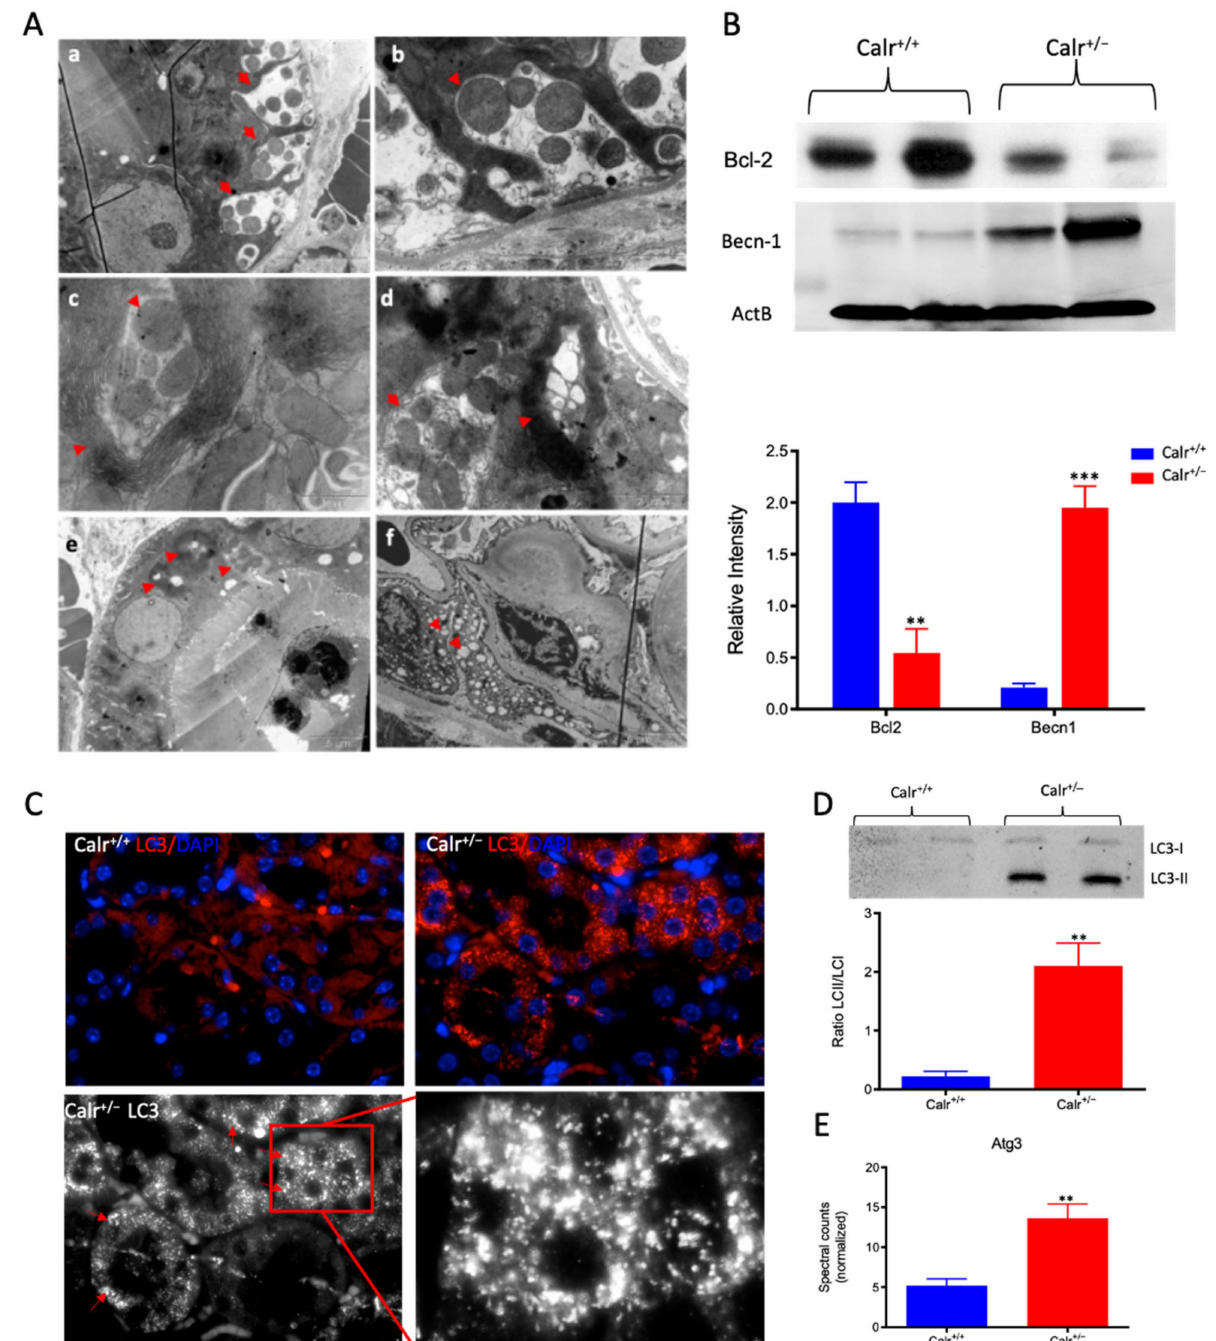
Figure 6. Severe mitochondrial damage and autophagy in Calr +/ − mouse kidneys. ( A ): Represen- tative electron micrographs for ultrastructural morphology of mitochondria from Calr +/ − mouse kidney—( a , b ): distal convoluted tubule cells swelling mitochondria enclosed in membrane struc- tures, some of the mitochondria are in advanced stages of autophagy; ( c – e ): damaged mitochondrial enclosed in multi-membrane structure undergoing autophagy, also shown are advanced stages where the mitochondria are almost completely eliminated; ( f ): a podocyte with damaged vacuolated mitochondria highlighted with red asterisks in Calr +/ − mouse kidneys. ( B ): Western blot analysis of protein extract from Calr +/+ and Calr +/ − kidney tissue showed down-regulation of Bcl-2 and up-regulation of Becn-1, indicating an activation of the autophagy. ( C ): Immunofluorescence staining of LC3 confirmed the initiation and formation of autophagosomes. ( D ): Western blot analysis with antibody against LC3 confirmed the shift toward LC3-II in Calr +/ − kidney, as evidenced by the